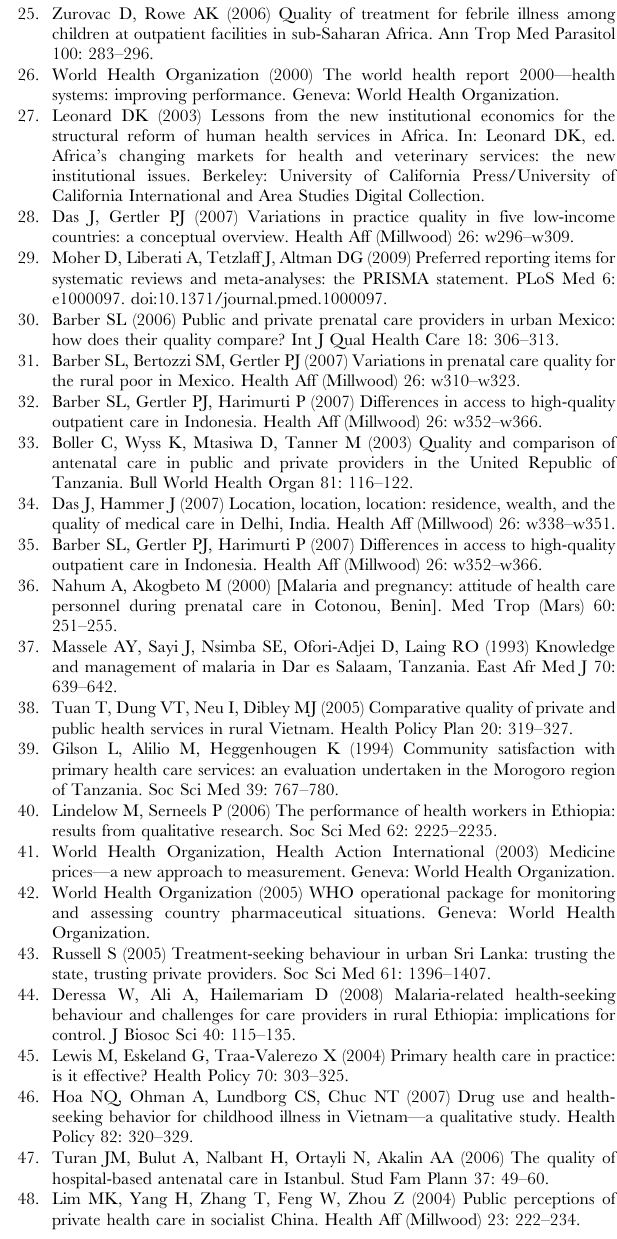
Table S9 Characteristics of included quantitative studies summarised by world